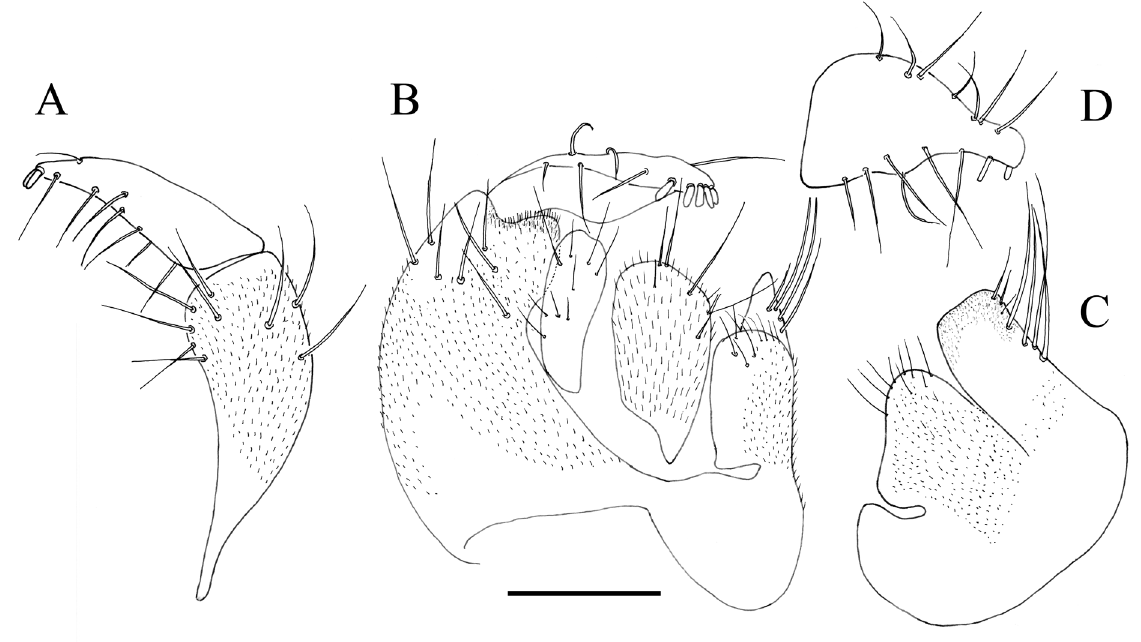
Fig. 7. Terminalia of Tachydromia iberica (Arias, 1919) from Spain, Segovia, El Espinar (Central System) (RBINS). A . Right surstylus and right epandrial lamella. B . Epandrium with cerci. C . Left epandrial lamella and left surstylus. D . Right surstylus. Scale bar: